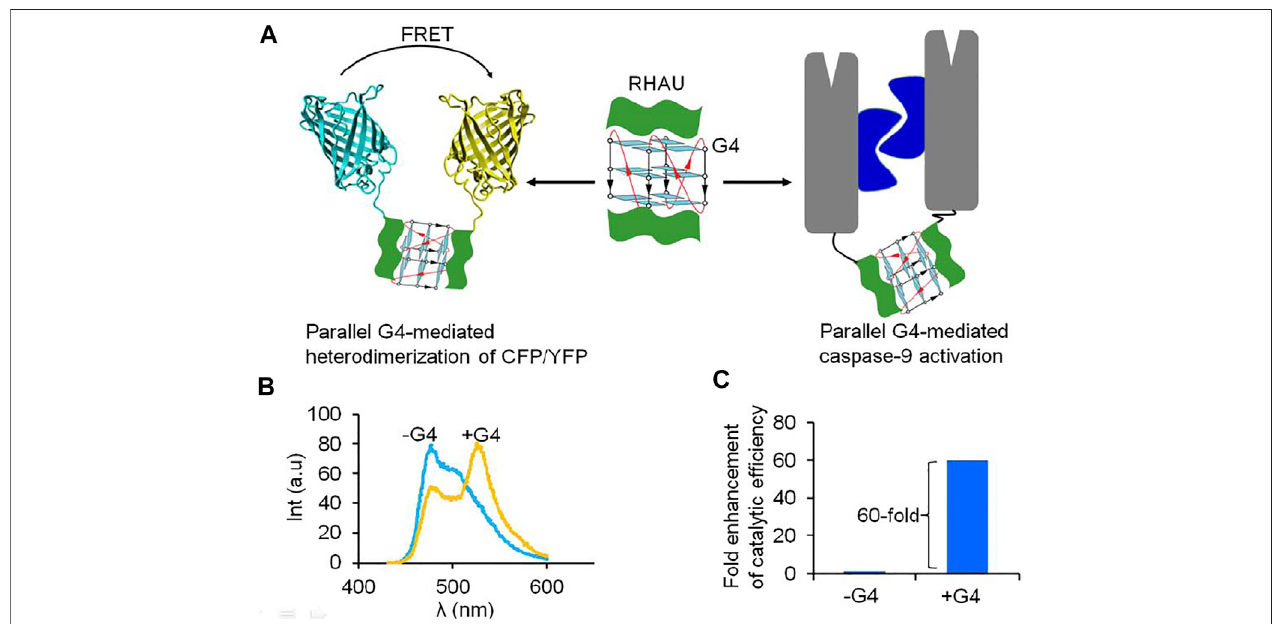
FIGURE 4 | Parallel G4 can act as a target-inducer of dimerization and activation of proteins fusing with RHAU peptide. (A) Schematic representation of dimerization of protein and activation via G4, (B) FRET signal was observe under addition of G4 to a mixture of RHAU-CFP/RHAU-YFP (Truong et al., 2020); (C) G4 can play as a target molecule for inducing both dimerization and rearrangement of the active site of RHAU-caspase-9, resulting in enhancement of catalytic ef fi ciency of enzyme (Truong et al., 2020).